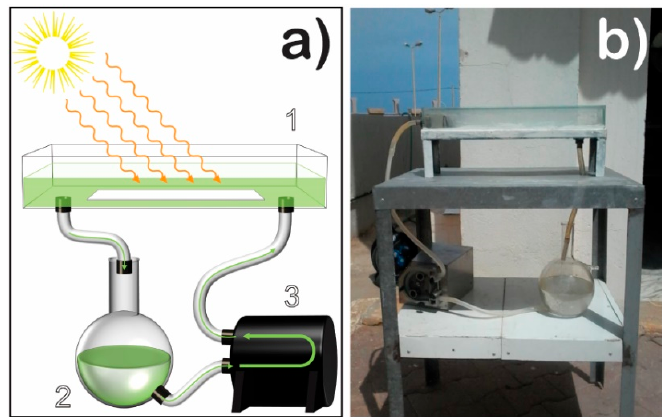
Figure 1. Representation of the solar photoreactor: ( a ) (1) photoreactor tank with the photocatalytic membrane at the bottom; (2) oily wastewater; (3) peristaltic pump; ( b ) a picture of the real photoreactor setup.